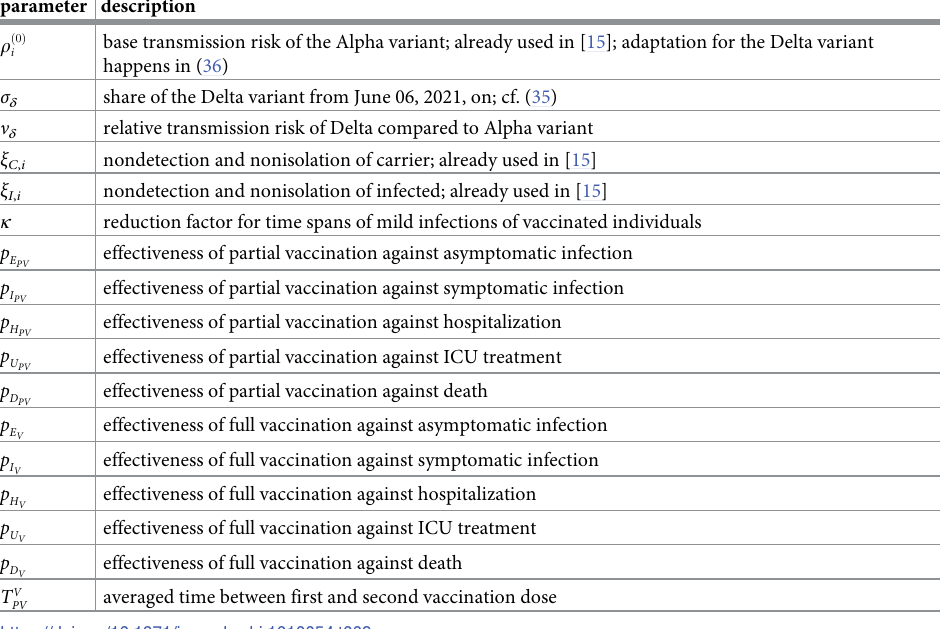
Table 2. New parameters for the local SIR-type model. Description of new or modified (in comparison to [6]) parameters. parameter description base transmission risk of the Alpha variant; already used in [15]; adaptation for the Delta variant r ð 0 Þ i happens in (36) σ δ share of the Delta variant from June 06, 2021, on; cf. (35) ν δ relative transmission risk of Delta compared to Alpha variant ξ C , i nondetection and nonisolation of carrier; already used in [15] ξ I , i nondetection and nonisolation of infected; already used in [15] κ reduction factor for time spans of mild infections of vaccinated individuals effectiveness of partial vaccination against asymptomatic infection p E PV effectiveness of partial vaccination against symptomatic infection p I PV effectiveness of partial vaccination against hospitalization p H PV effectiveness of partial vaccination against ICU treatment p U PV effectiveness of partial vaccination against death p D PV effectiveness of full vaccination against asymptomatic infection p E V effectiveness of full vaccination against symptomatic infection p I V effectiveness of full vaccination against hospitalization p H V effectiveness of full vaccination against ICU treatment p U V effectiveness of full vaccination against death p D V averaged time between first and second vaccination dose T V PV